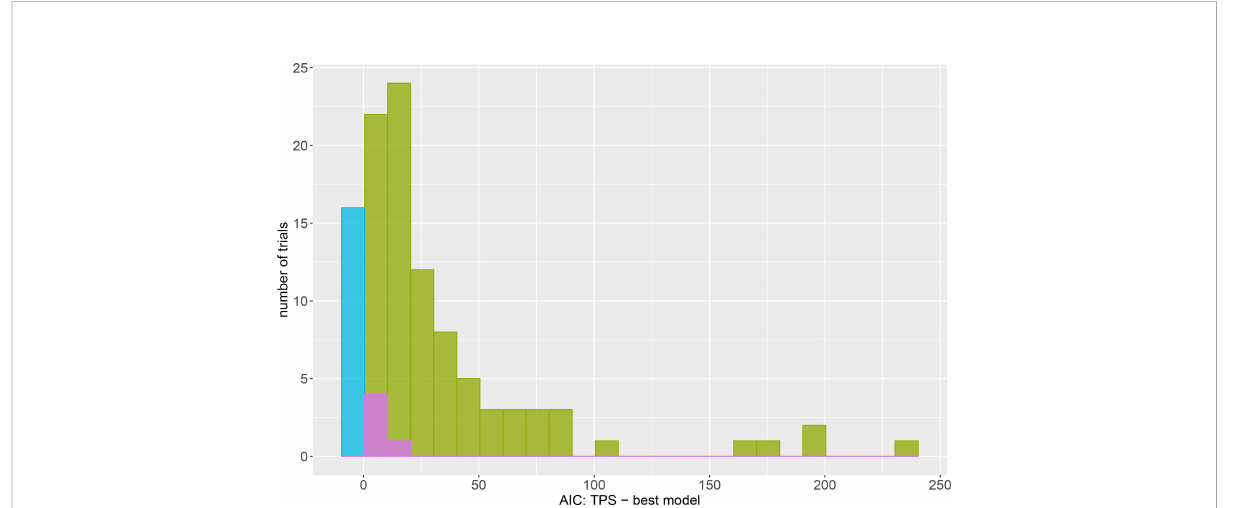
FIGURE 1 Histogram of the difference in AIC between the TPS model and the model with the lowest AIC within the set of four models. The blue bar at zero is for the trials where the TPS model was the best fi tting model based on AIC. The green bars are for trials where the A×A or A×Ae model were the best model. Purple is for the fi ve trials where the baseline model was the best